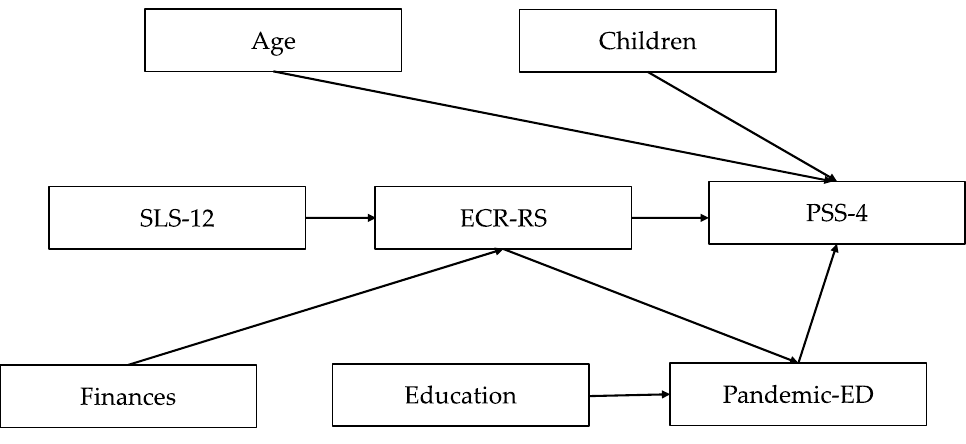
Figure 1. The theoretical framework of the SEM model.